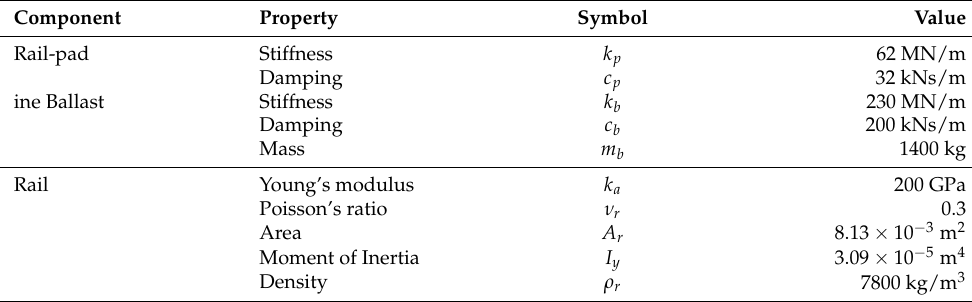
Table 2. Mechanical properties for track